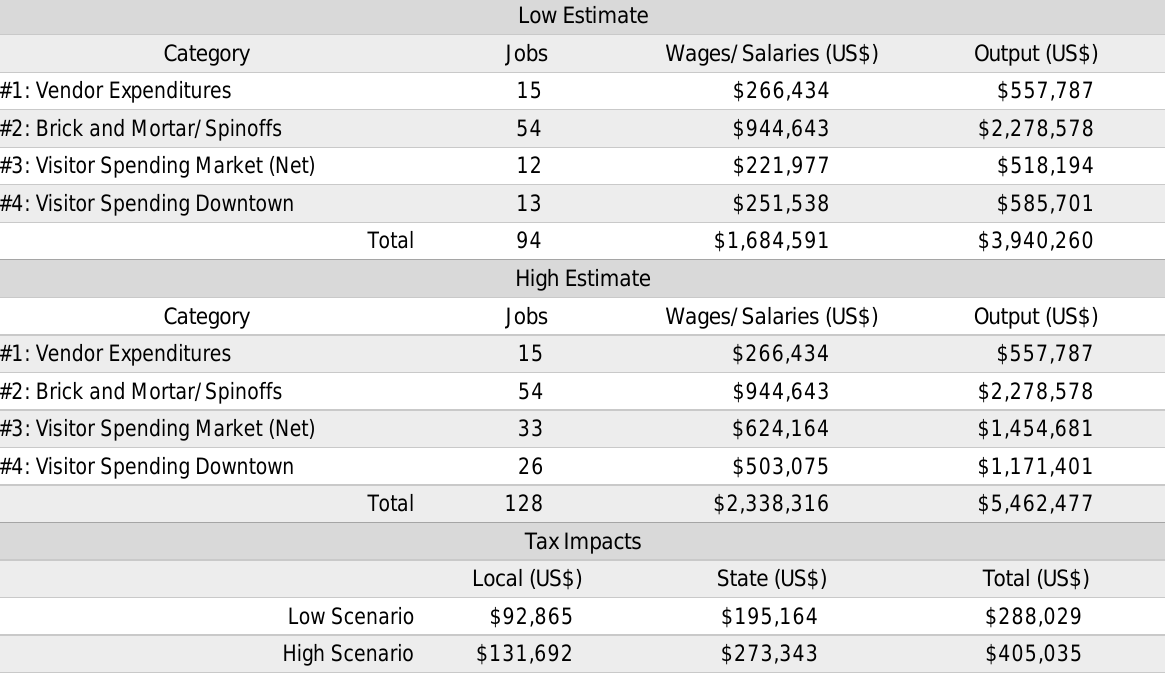
Table 2. Economic Impacts of Moscow Farmers Market (Low and High Estimates), Includes the Direct, Indirect and Induced